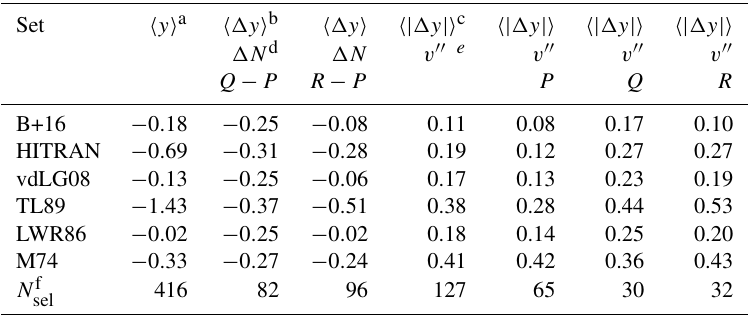
Table 1. Comparison of populations y and population ratios (cid:49)y with respect to changes in branch and v (cid:48)(cid:48) for six sets of Einstein- A coeffi- cients.